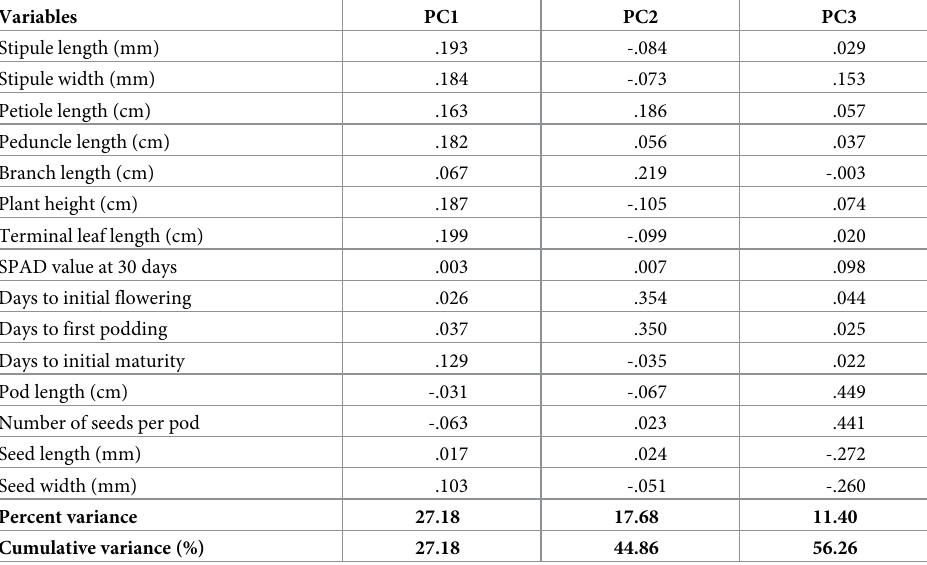
Table 3. Principal Component (PC) matrix explaining loading of variables.